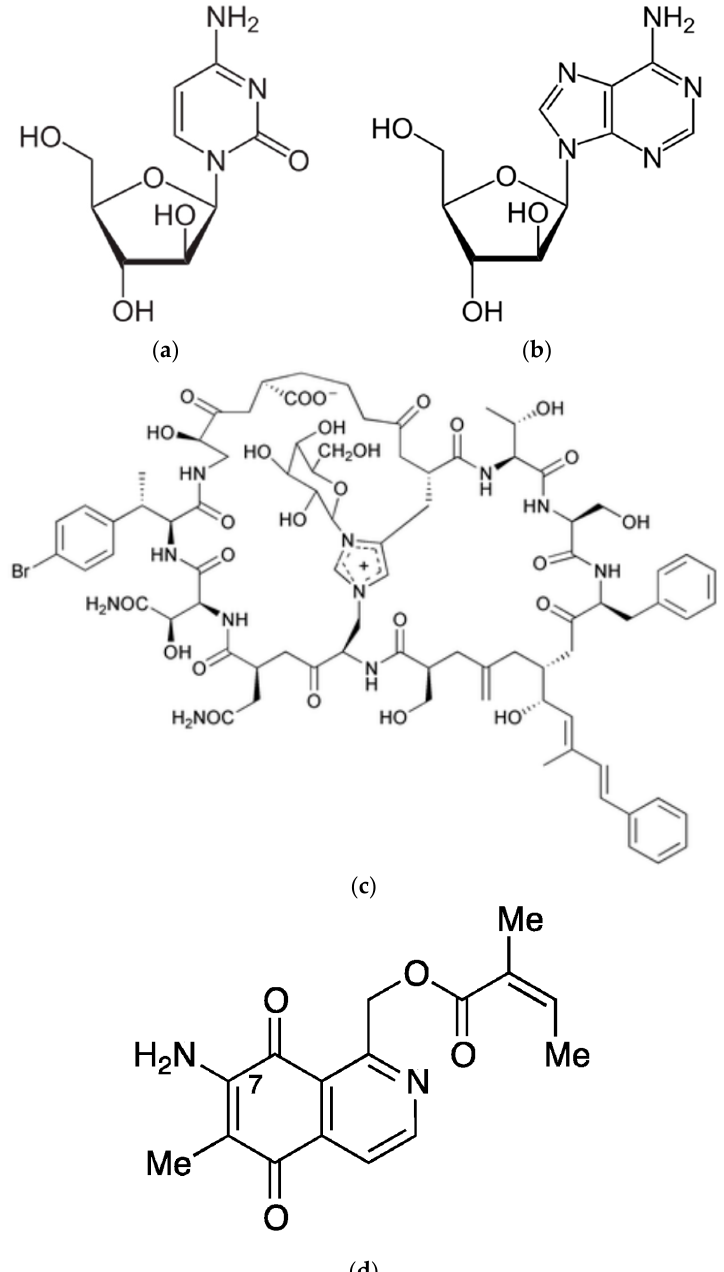
Figure 1. The molecular structure of sponge-derived compounds ( a ) Ara-C (cytarabine) an anticancer agent; ( b ) Ara-A (vidarabine) an antiviral agent [119]; ( c ) theopalauamide an antifungal agent [110]; and ( d ) cibrostatin 3 an antibacterial agent [120].